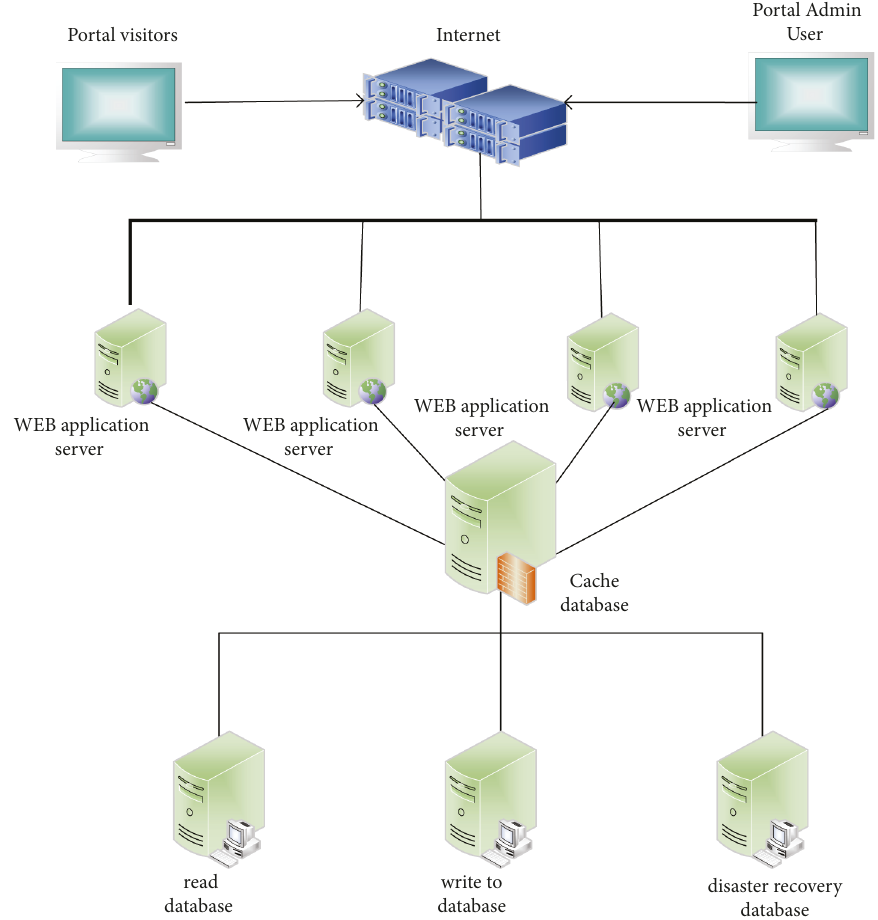
Figure 2: Traditional Chinese medicine cloud health platform